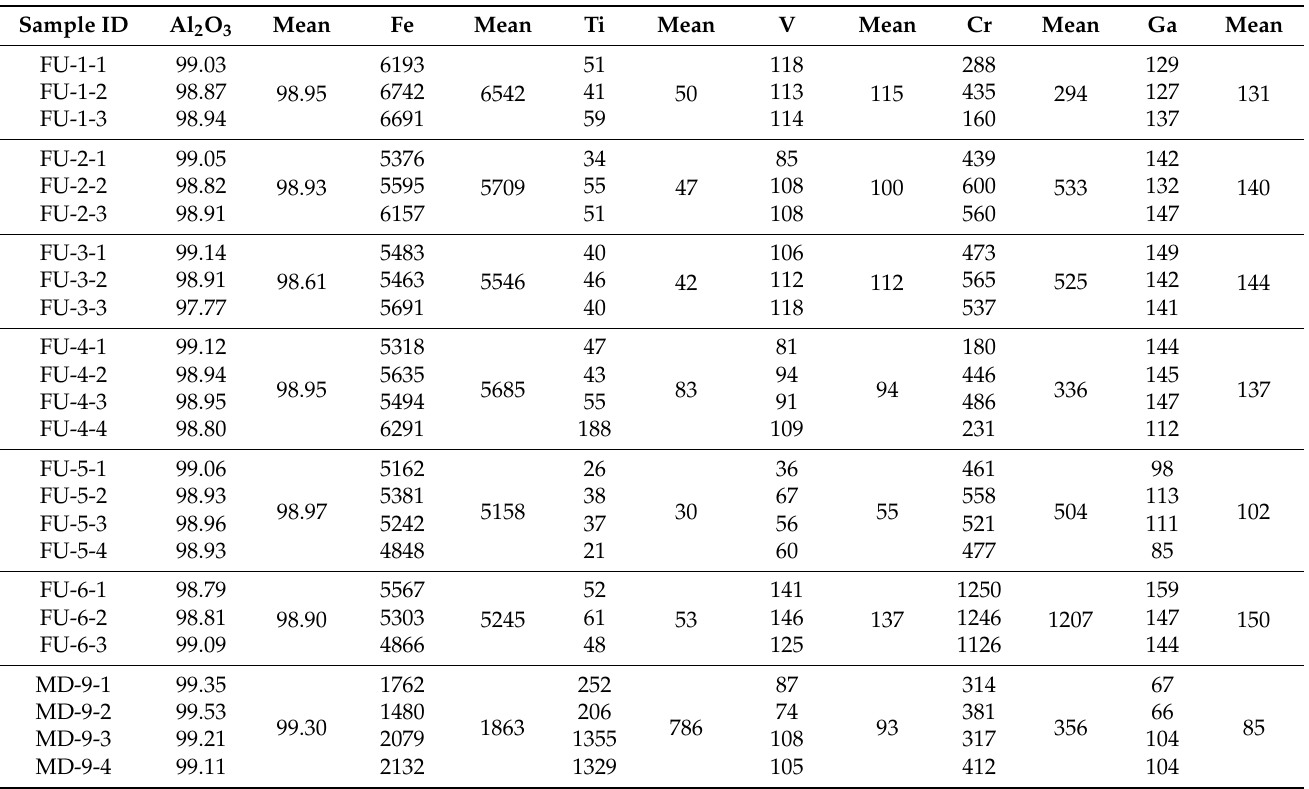
Table 1. Major and trace element compositions of color-change sapphires from the Fuping, China and Mogok,